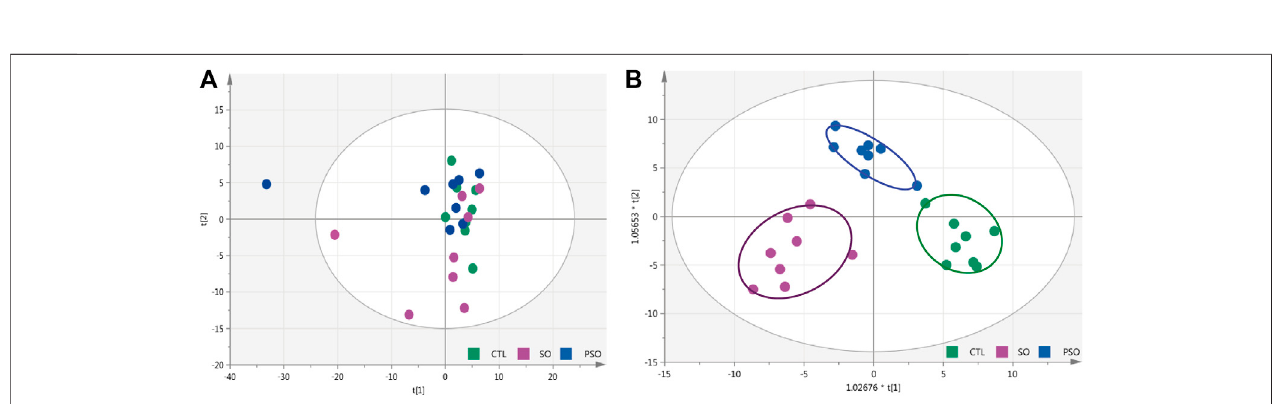
FIGURE 3 | PCA and OPLS-DA modeling were used to differentiate the rat serum metabolomic patterns after raw SO and PSO treatment. (A) PCA modeling; (B) OPLS-DA modeling. Control group (green), raw SO group (violet), and PSO group (blue).